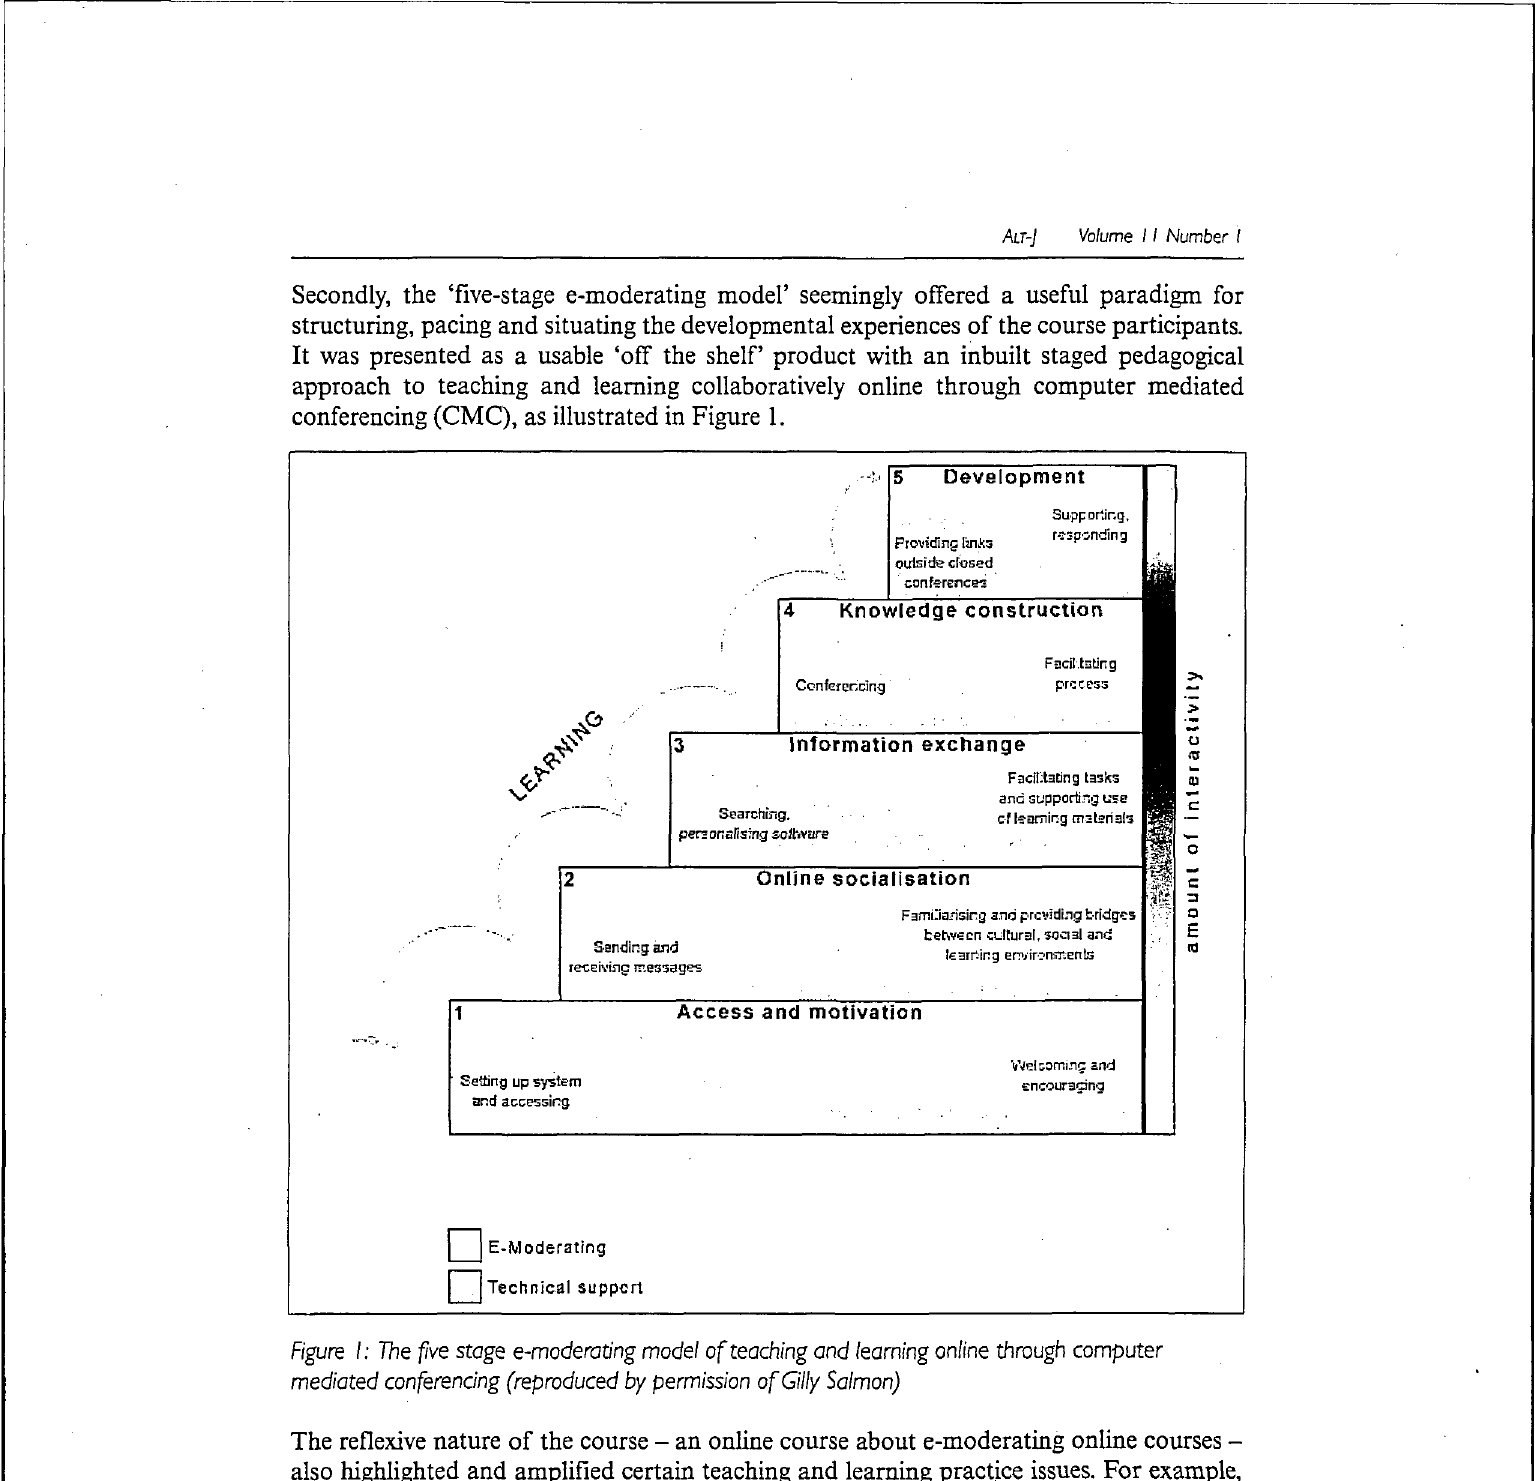
Figure /: The five stage e-moderating model of teaching and learning online through computer mediated conferencing (reproduced by permission ofGilly